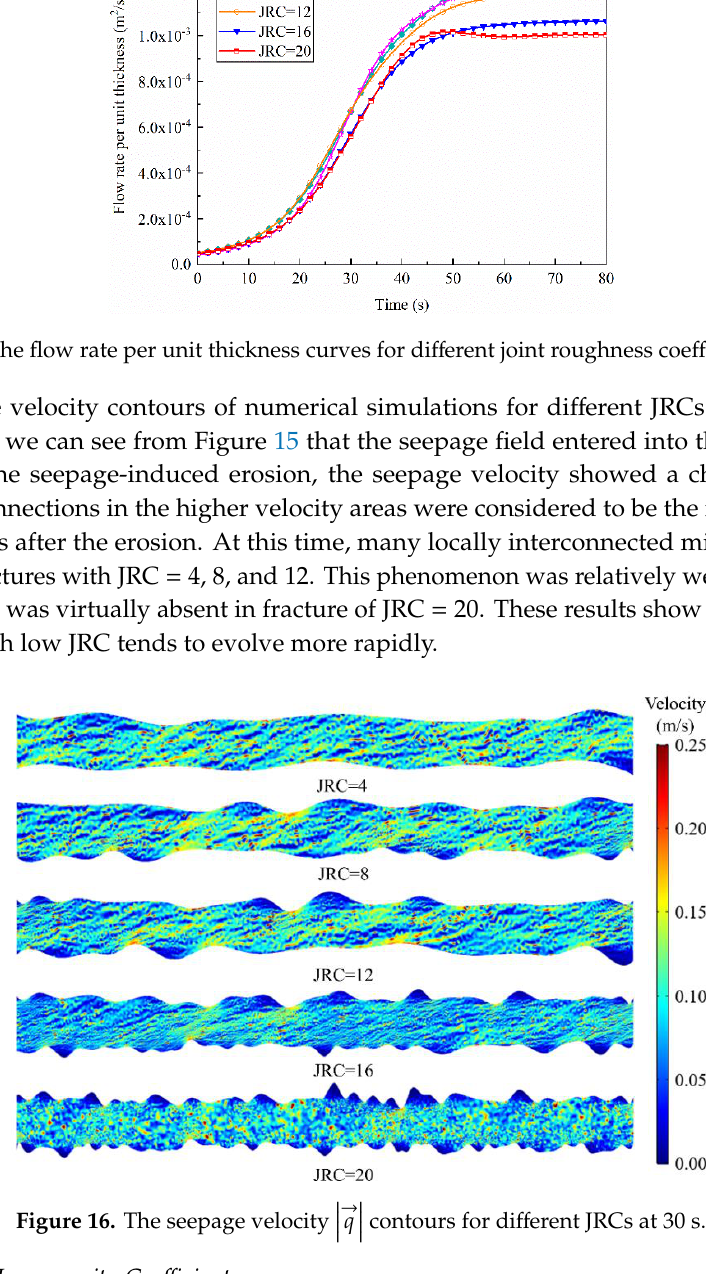
Figure 16. The seepage velocity |𝑞⃗| contours for different JRCs at 30 s.